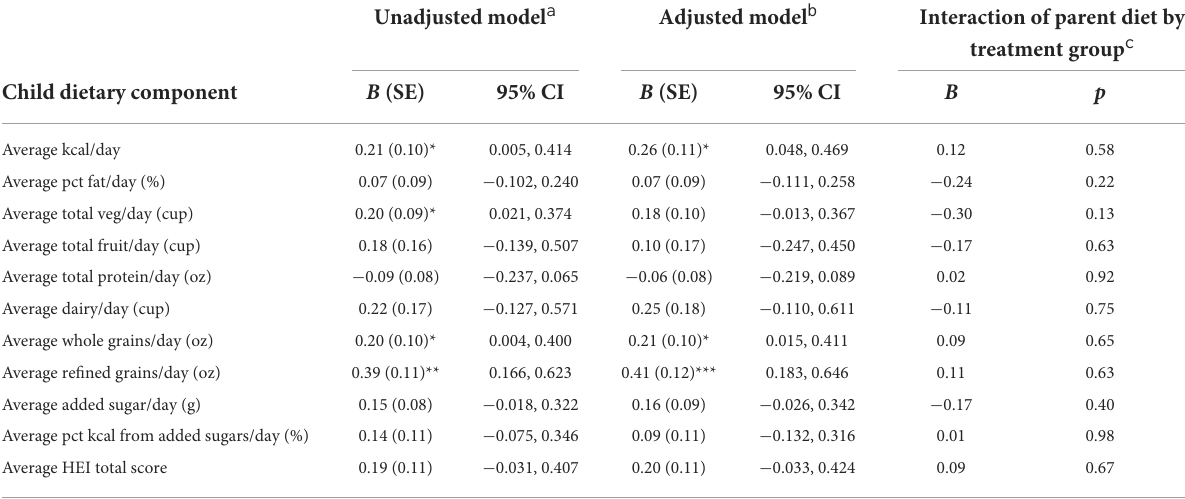
TABLE 4 Association between parent (IV) and child dietary component (DV) changes from baseline to 6 months and interaction by treatment group. Unadjusted model a Adjusted model b Interaction of parent diet by treatment group